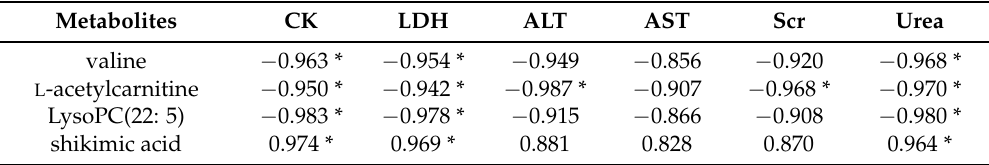
Figure 4. The variation trends of biomarkers’ relative contents (peak area intensities) in Radix Aconiti ethanol extraction groups with different doses. Significant difference from control: * p < 0.05, ** p < 0.01. NS: Normal Saline; A: 2 g/kg ethanol extraction; B: 5 g/kg ethanol extraction; C: 10 g/kg ethanol extraction. Table 3. The correlation of biochemical indicators and endogenous biomarkers.